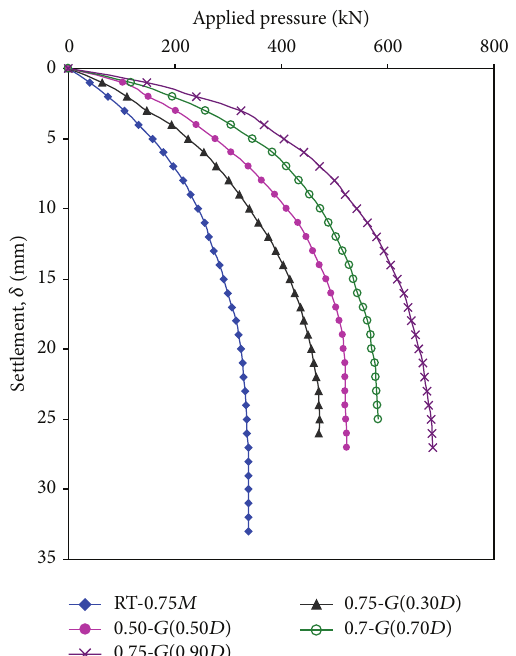
Figure 12: Load-settlement curve for Series III ( 𝐷 = 0.50 𝑀 ),